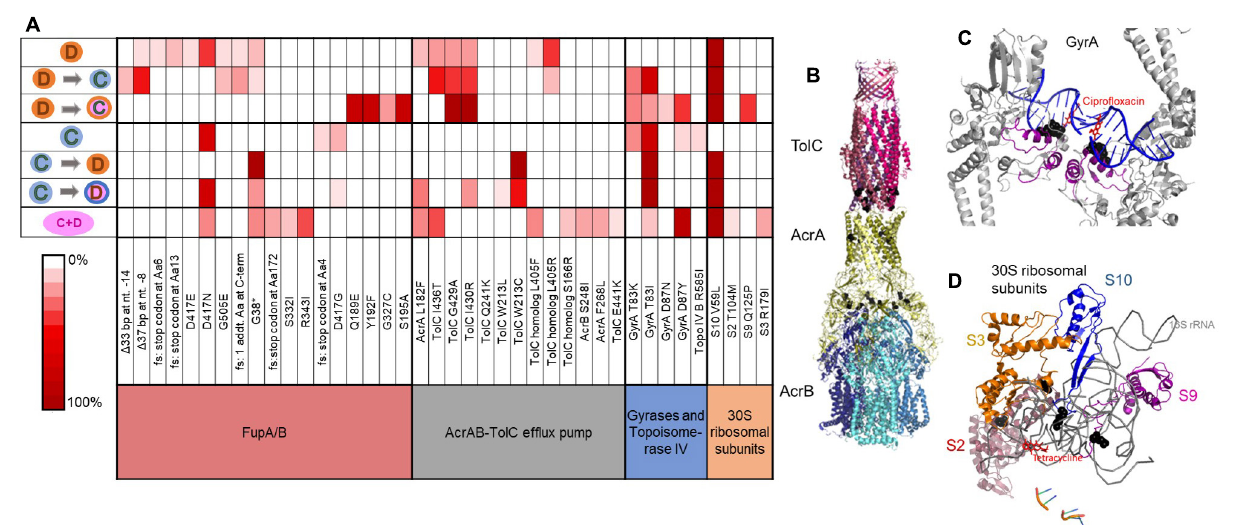
FIGURE 3 | Mutation categories involved in resistance and distribution of mutant alleles among end point isolates obtained from different selection conditions. (A) Heat map shows the frequency of non-synonymous mutant alleles within a mutation category identified in end point isolates obtained from each selection condition. 2–4 end point isolates from each of the five replicate populations and seven selection environments were sequenced. Each row represents one condition and symbols for selection conditions are those used in Figure 1 . fs, frameshift; TolC homolog, FTL_1107. (B) Mutations observed in AcrAB-TolC in adapted LVS isolates mapped onto the protein structure for this efflux pump from E. coli (PDB: 5V5S). Positions of mutations are indicated (black spheres). Most mutations are proximal to subunit interfacial contact regions that are implicated in allosteric control of the effluxer (Wang et al., 2017). (C) Mutations observed in GyrA in adapted LVS isolates mapped onto the protein structure of GyrA from Staphylococcus aureus bound to ciprofloxacin (PDB: 2XCT). Adaptive mutations are directly proximal to the ciprofloxacin binding pocket of the gyrase (black spheres). (D) 30S ribosomal subunits S2, S3, S9, and S10 from Thermus thermophilus interacting with tetracycline (PDB: 1HNW). Mutant residues identified in LVS adapted strains are mapped onto this structure and are shown in black spheres. They are mostly found in loop regions interacting with the 16s rRNA that directly comprises part of the tetracycline binding pocket of the 30S